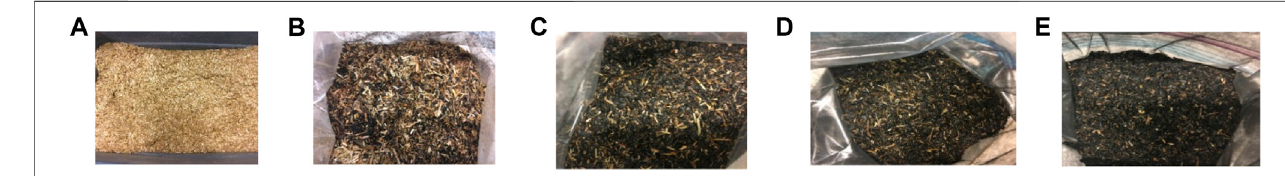
FIGURE 1 | Raw and microwave-torre fi ed wheat and barley straw biochar-mix (A) ground biomass; (B) torre fi ed biomass without biochar; (C) torre fi ed biomass with 10% biochar; (D) torre fi ed biomass with 15% biochar; (E) torre fi ed biomass with 25% biochar.